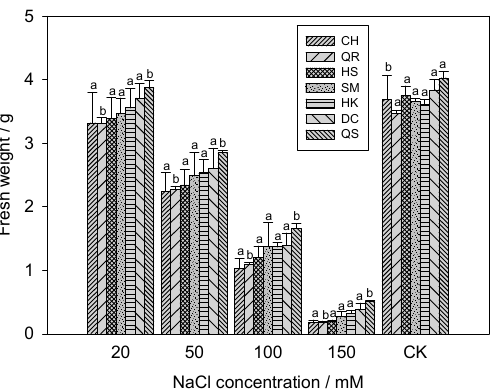
Figure 4. The fresh weight (g) of E. crus-galli with four NaCl concentrations at 21 days after treatment. Lowercase letters are expressed as least square means ± standard error ( p < 0.05).